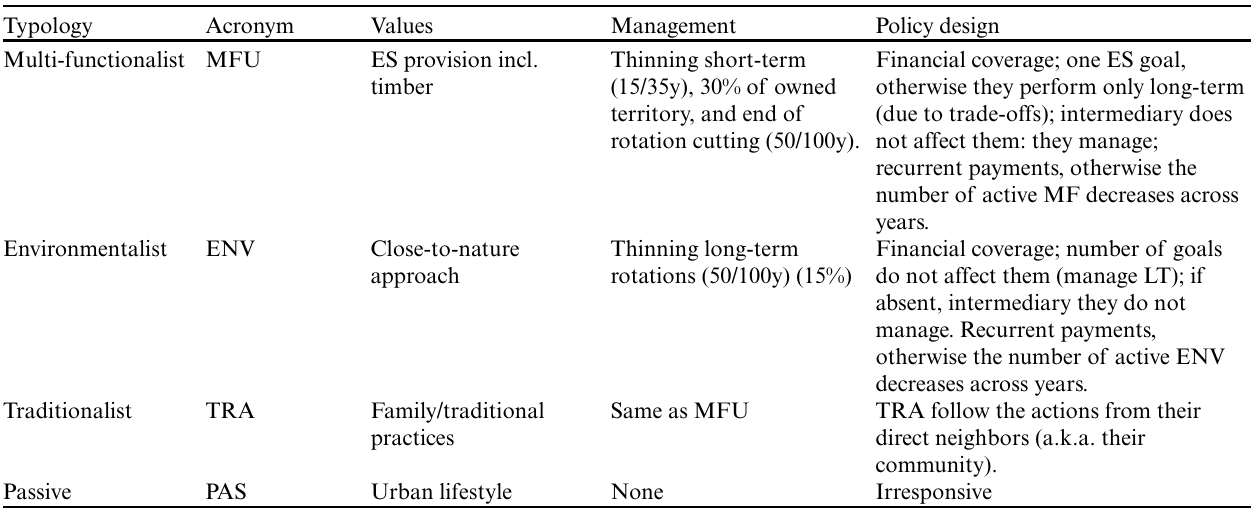
Table 3 . Forest owner behavior responses to policy